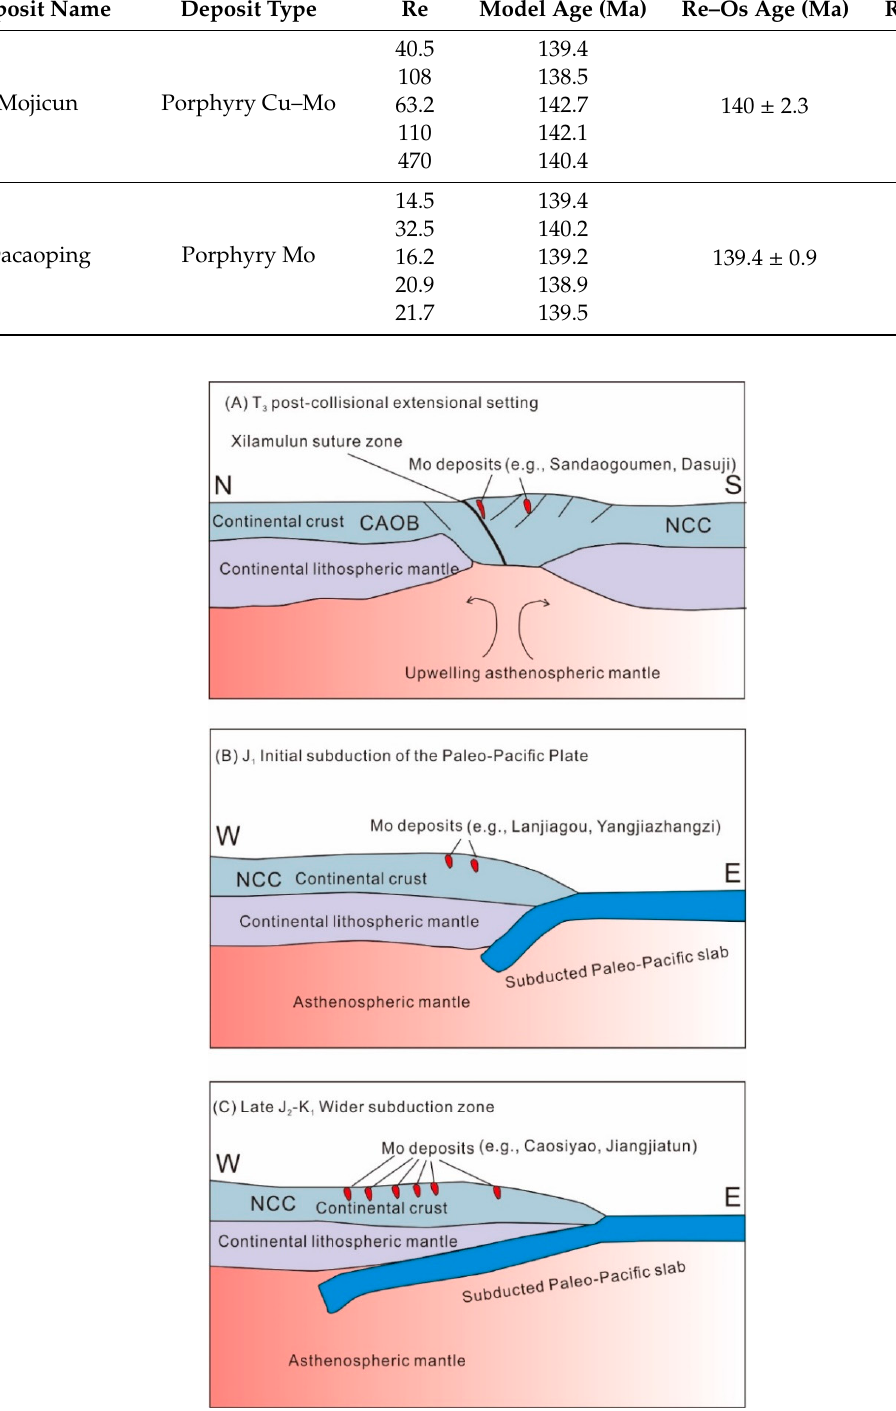
Figure 10. Three stages of genetic model of the Yan-Liao metallogenic belt, North China Craton. ( A )The post-collisional setting in response to the closure of the Paleo-Asian ocean during Late Triassic Period; ( B ) The narrow subduction zone in response to the paleo-Pacific plate during Early Jurassic Period; ( C ) The wide subduction zone in response to the paleo-Pacific plate during Middle to Early Cretaceous periods. The Jiangjiatun Mo deposit was formed in the beginning period of the last stage of the large scale Mo mineralization. Abbreviations: CAOB—Central Asian Ocean Belt, NCC—North China